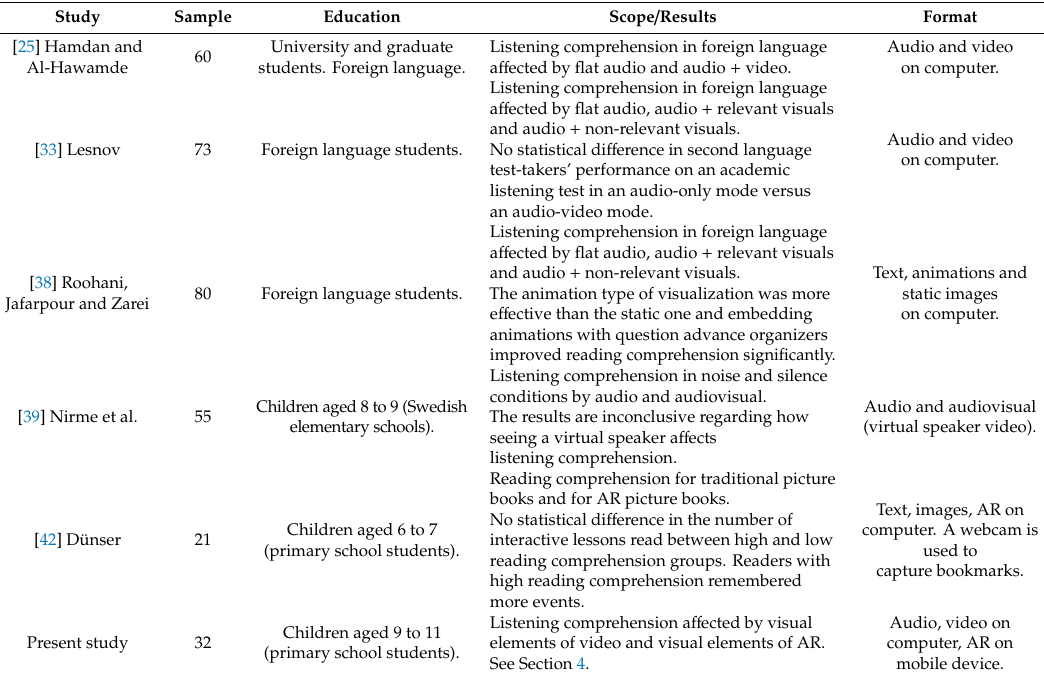
Table 1. Comparison of studies that explore the relationship between comprehension and visual support